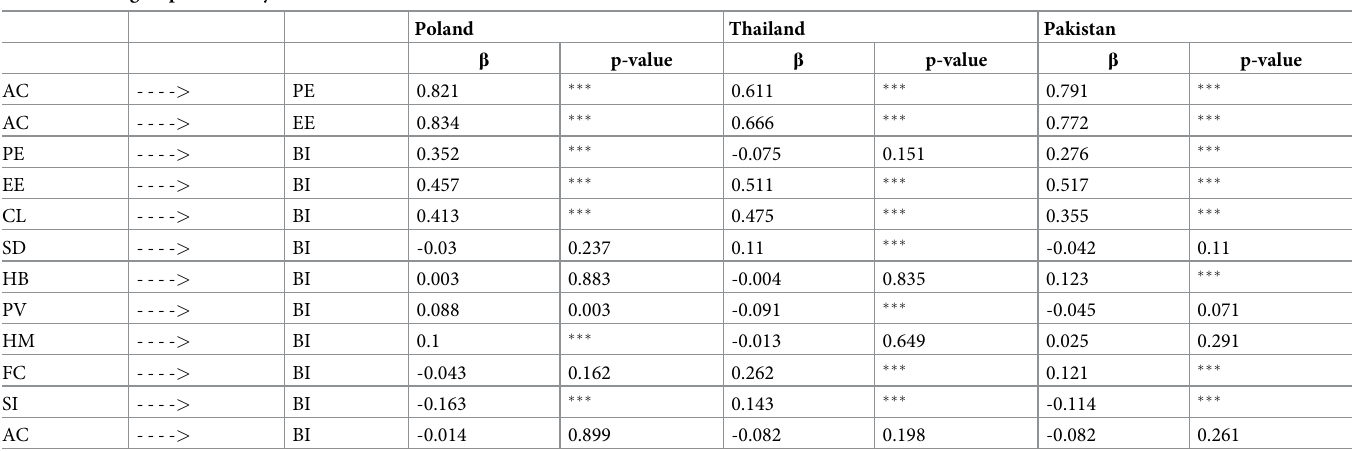
Table 8. Multi-group SEM analysis.